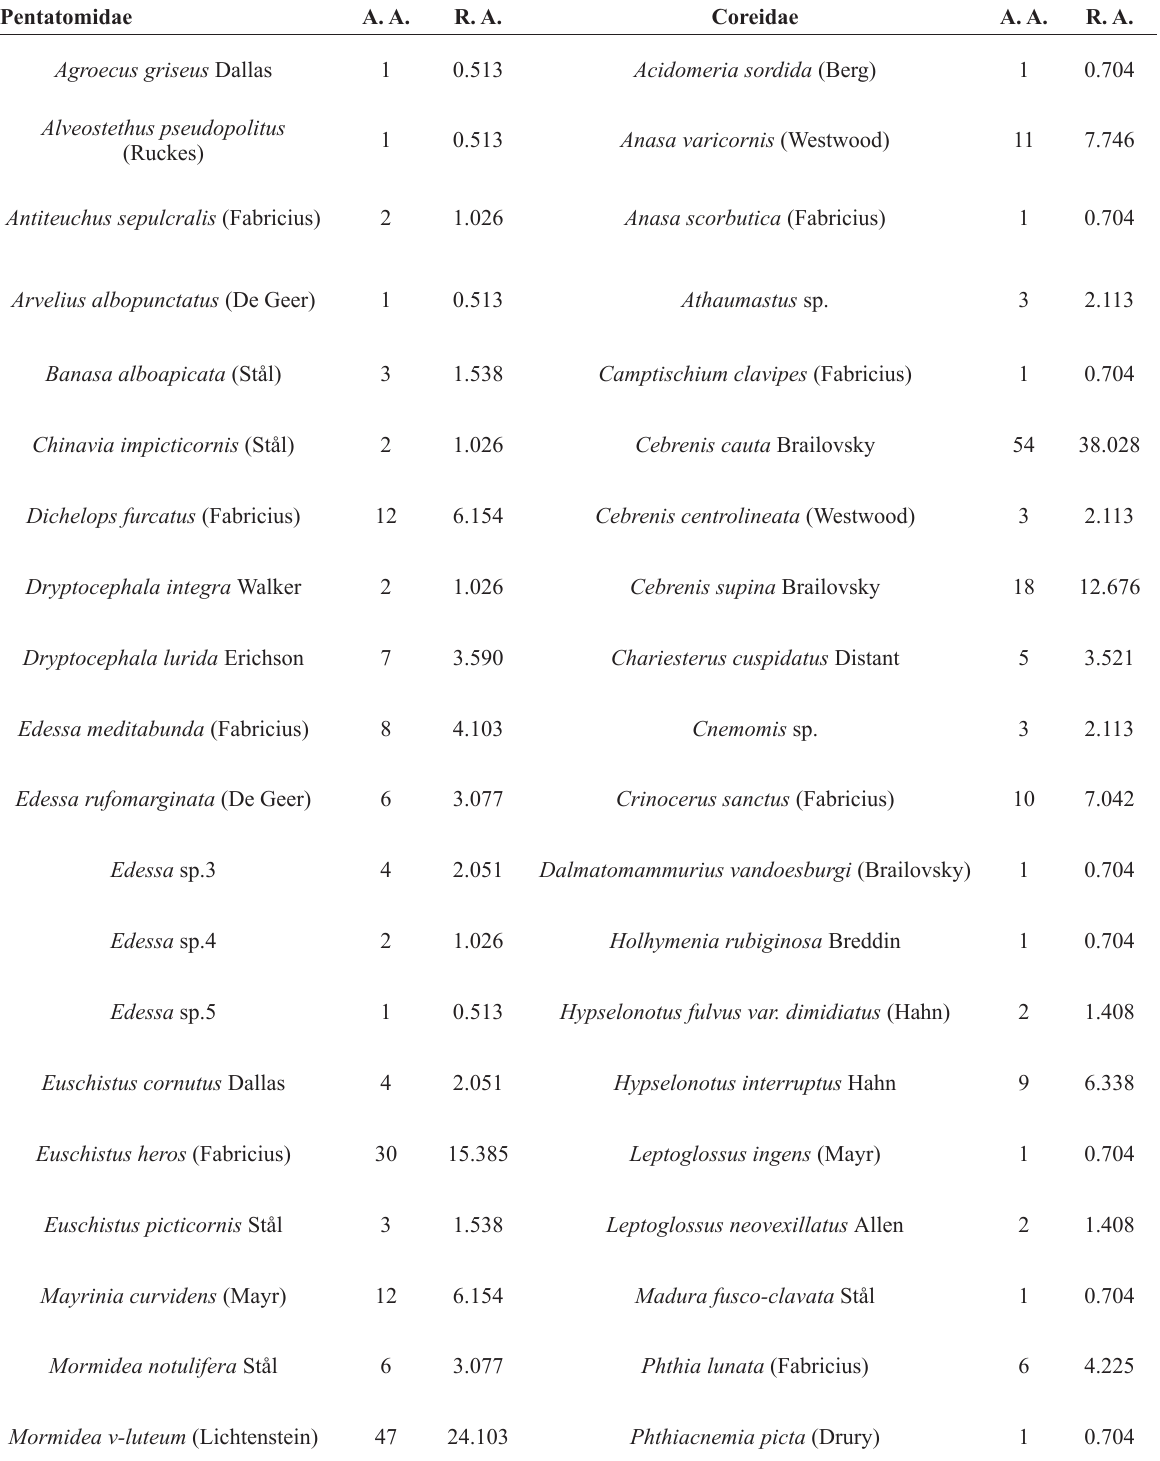
Species of Pentatomidae, Alydidae, Coreidae y Rhopalidae collected in Parque Provincial Moconá and their absolute